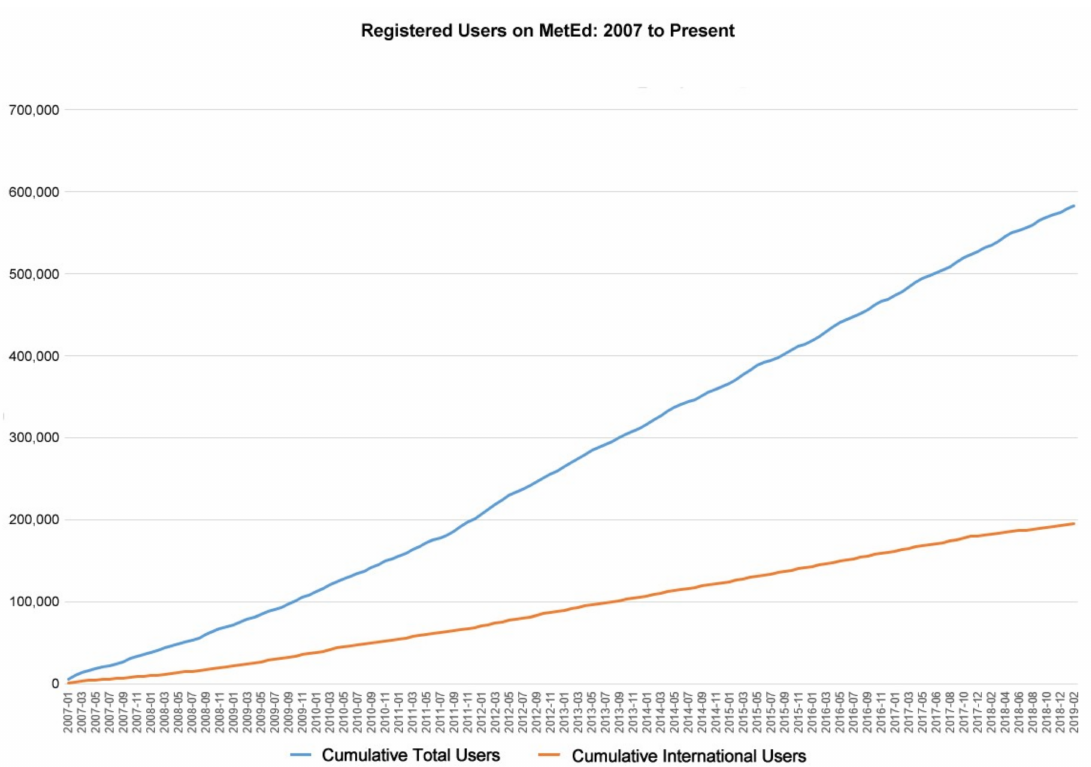
Figure 9. Cumulative number of users on MetEd from 2007 to present (April 2019). MetEd’s reach, both internationally and overall, has increased continuously, with approximately 600,000 learners currently registered on the